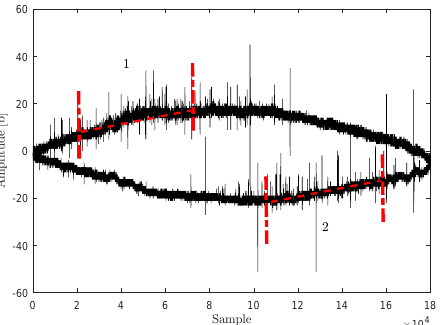
Figure 6. Selected parts of the 50 Hz carrier wave with the highest probability of PD activity